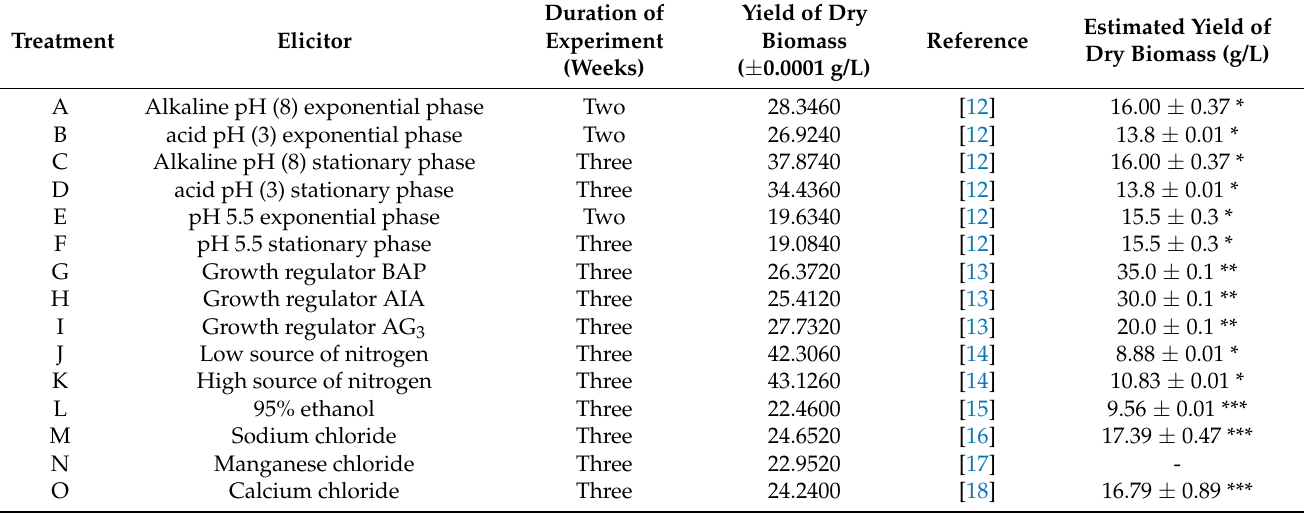
Table 1. List of elicitor treatments and comparison of yields with similar